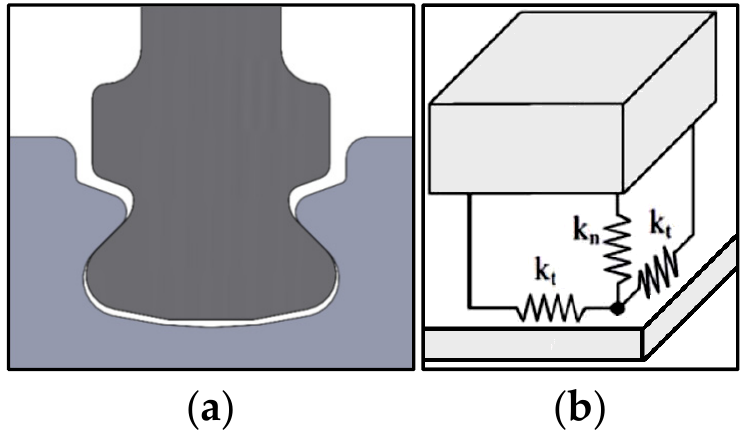
Figure 12. ( a ) A dovetail joint; ( b ) diagram of contact element.